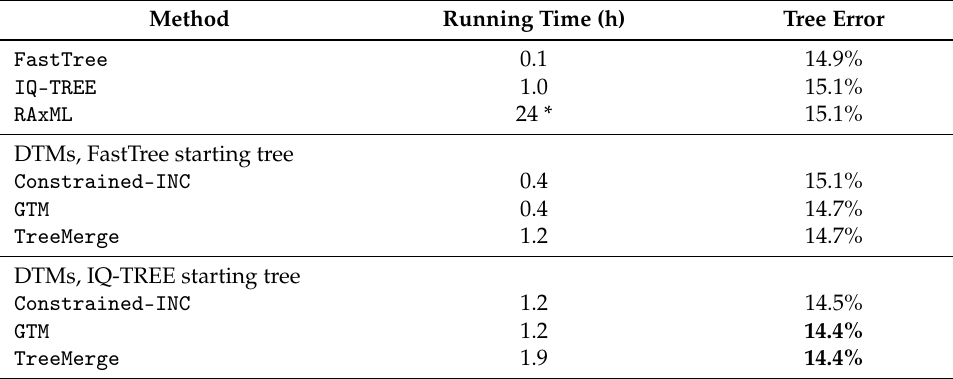
Table 3. Results on the RNASim1000 datasets. Tree error (FN) rates and running time for ML